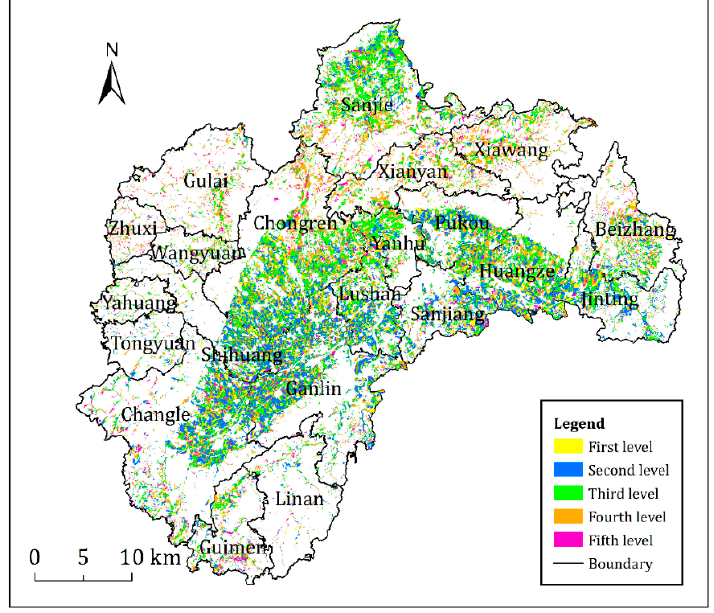
Figure 3. Distribution of the quality of cultivated land in the study area.